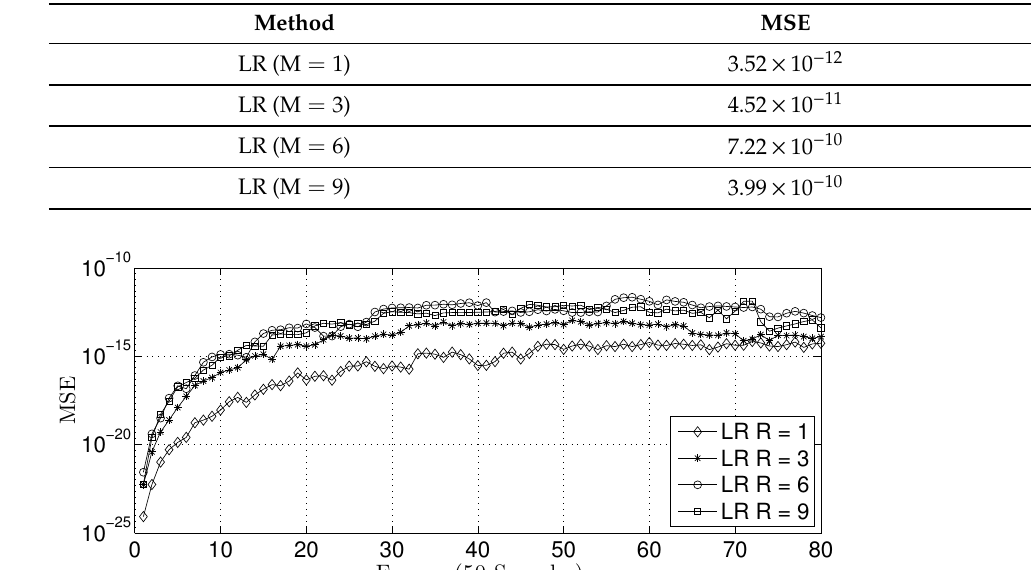
Table 9. Mean square error (MSE) between the software implementation and the proposed hardware implementation for LR technique.